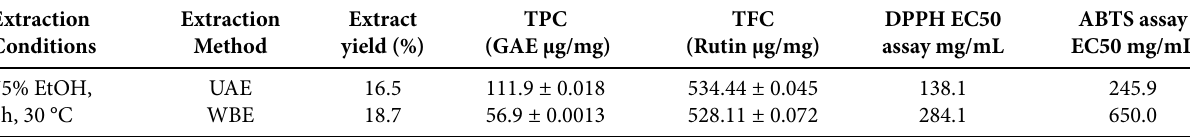
Table 1. Effect of UAE and WBE methods on antioxidant properties of olive leaf extract.